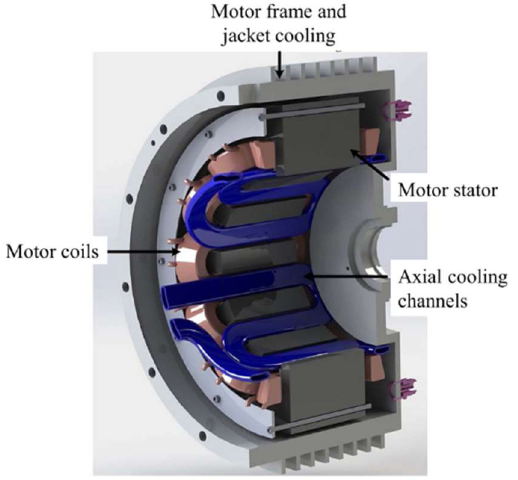
Figure 9. An electrical machine with U-shaped heat pipes [33].